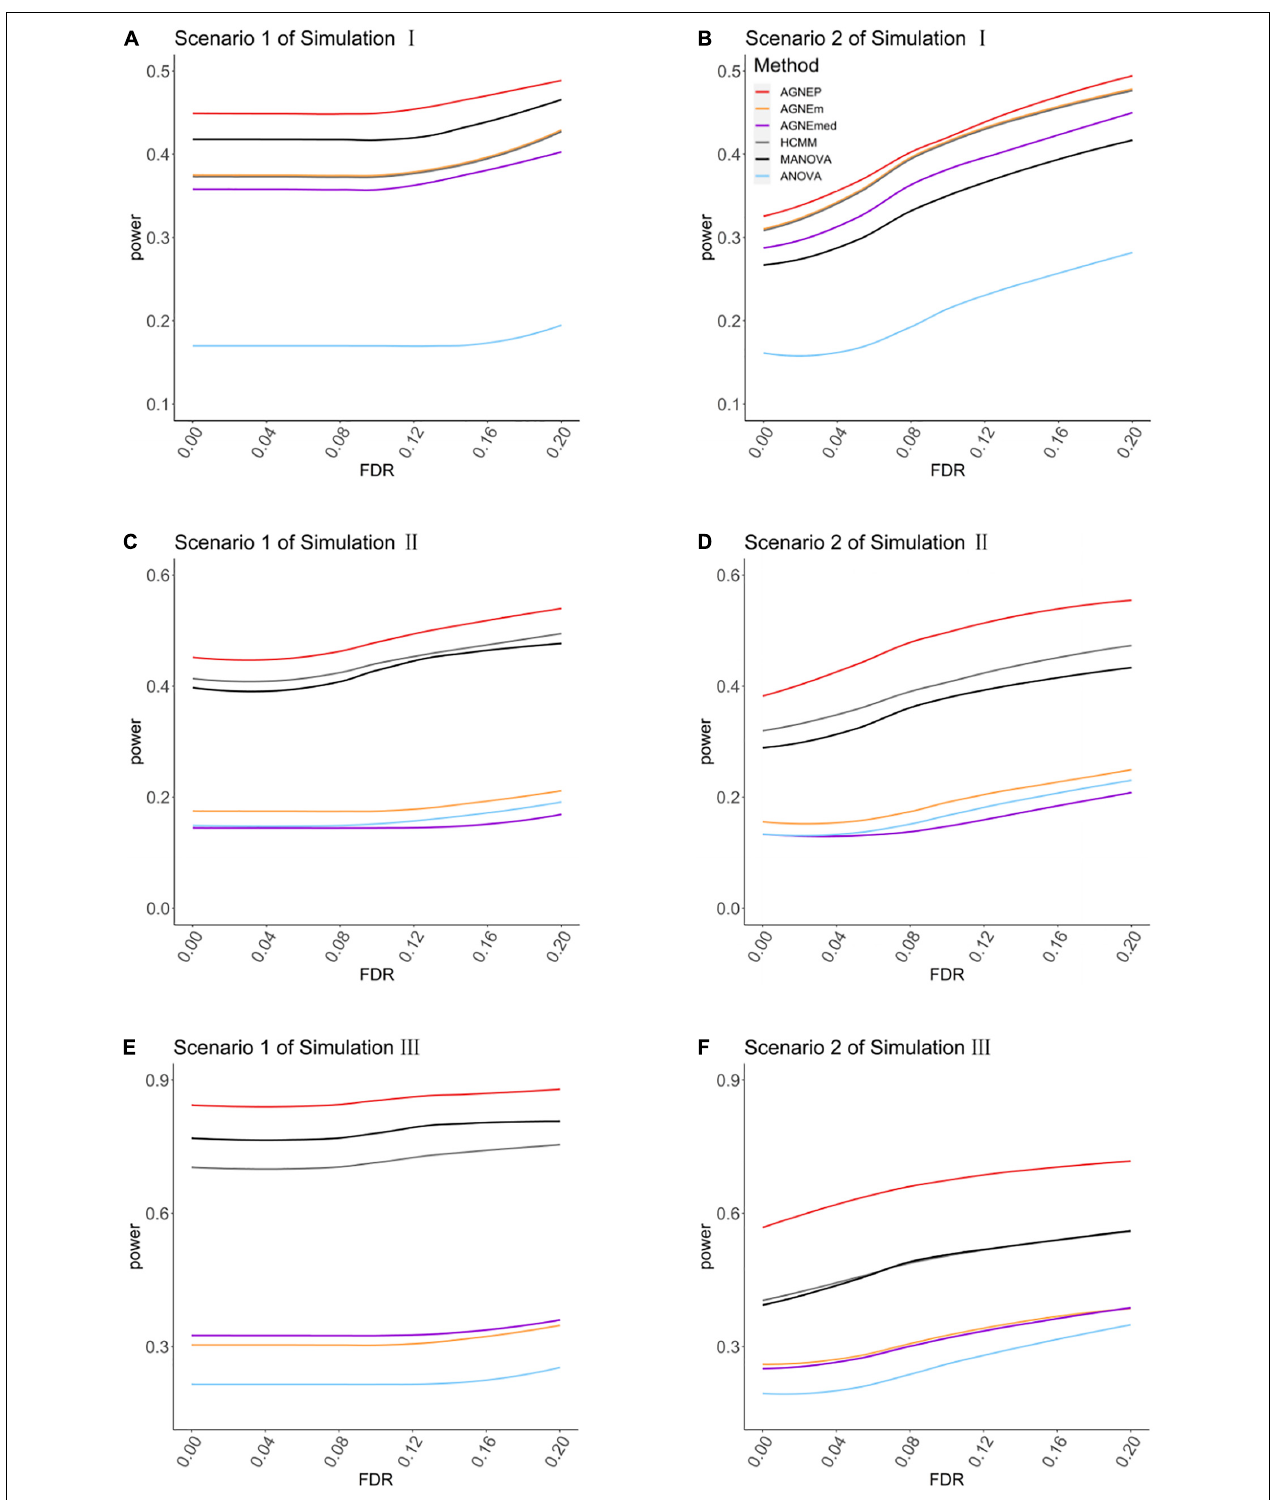
FIGURE 3 | The comparison of the power for AGNEP and established approaches. (A,B) The powers of simulation experiment I are presented. (C,D) The powers of simulation experiment II are presented. (E,F) The powers of simulation experiment III are presented. Scenario 1 and 2 indicate that 10 and 50 QTNs are simulated in the three simulations,